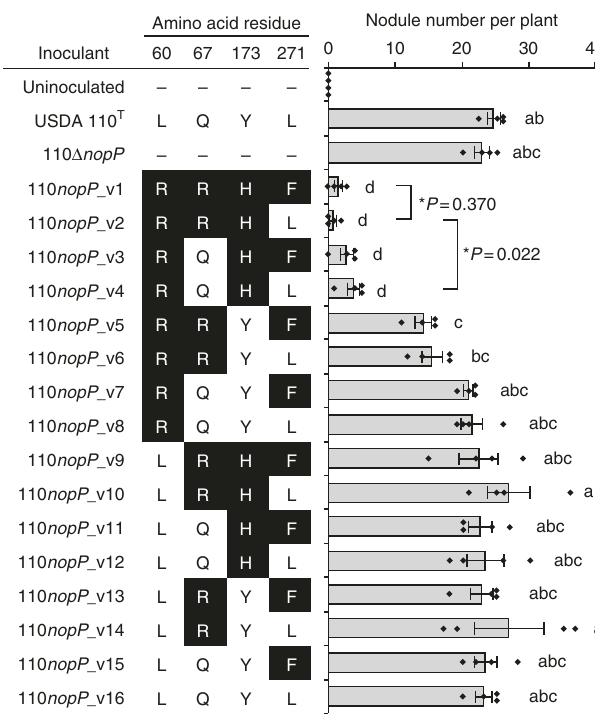
Fig. 7 Nodulation phenotypes of USDA 110 T carrying nopP variants on Hardee. Strains and amino acid residues in NopP at positions 60, 67, 173, and 271 are shown on the left, and the nodule numbers at 28 days after inoculation are shown on the right. Error bars show SEM ( n = 4). Different lowercase letters to the right of the bars indicate signi fi cant difference by one-way ANOVA followed by Tukey ’ s honestly signi fi cant difference test ( P < 0.05). The experiment was repeated once again with different comparison as second nodulation assay (Supplementaly Fig. 10a). The asterisks indicate the P -values calculated by two-tailed Student ’ s t -test based on the data from second nodulation assay ( n = 10)